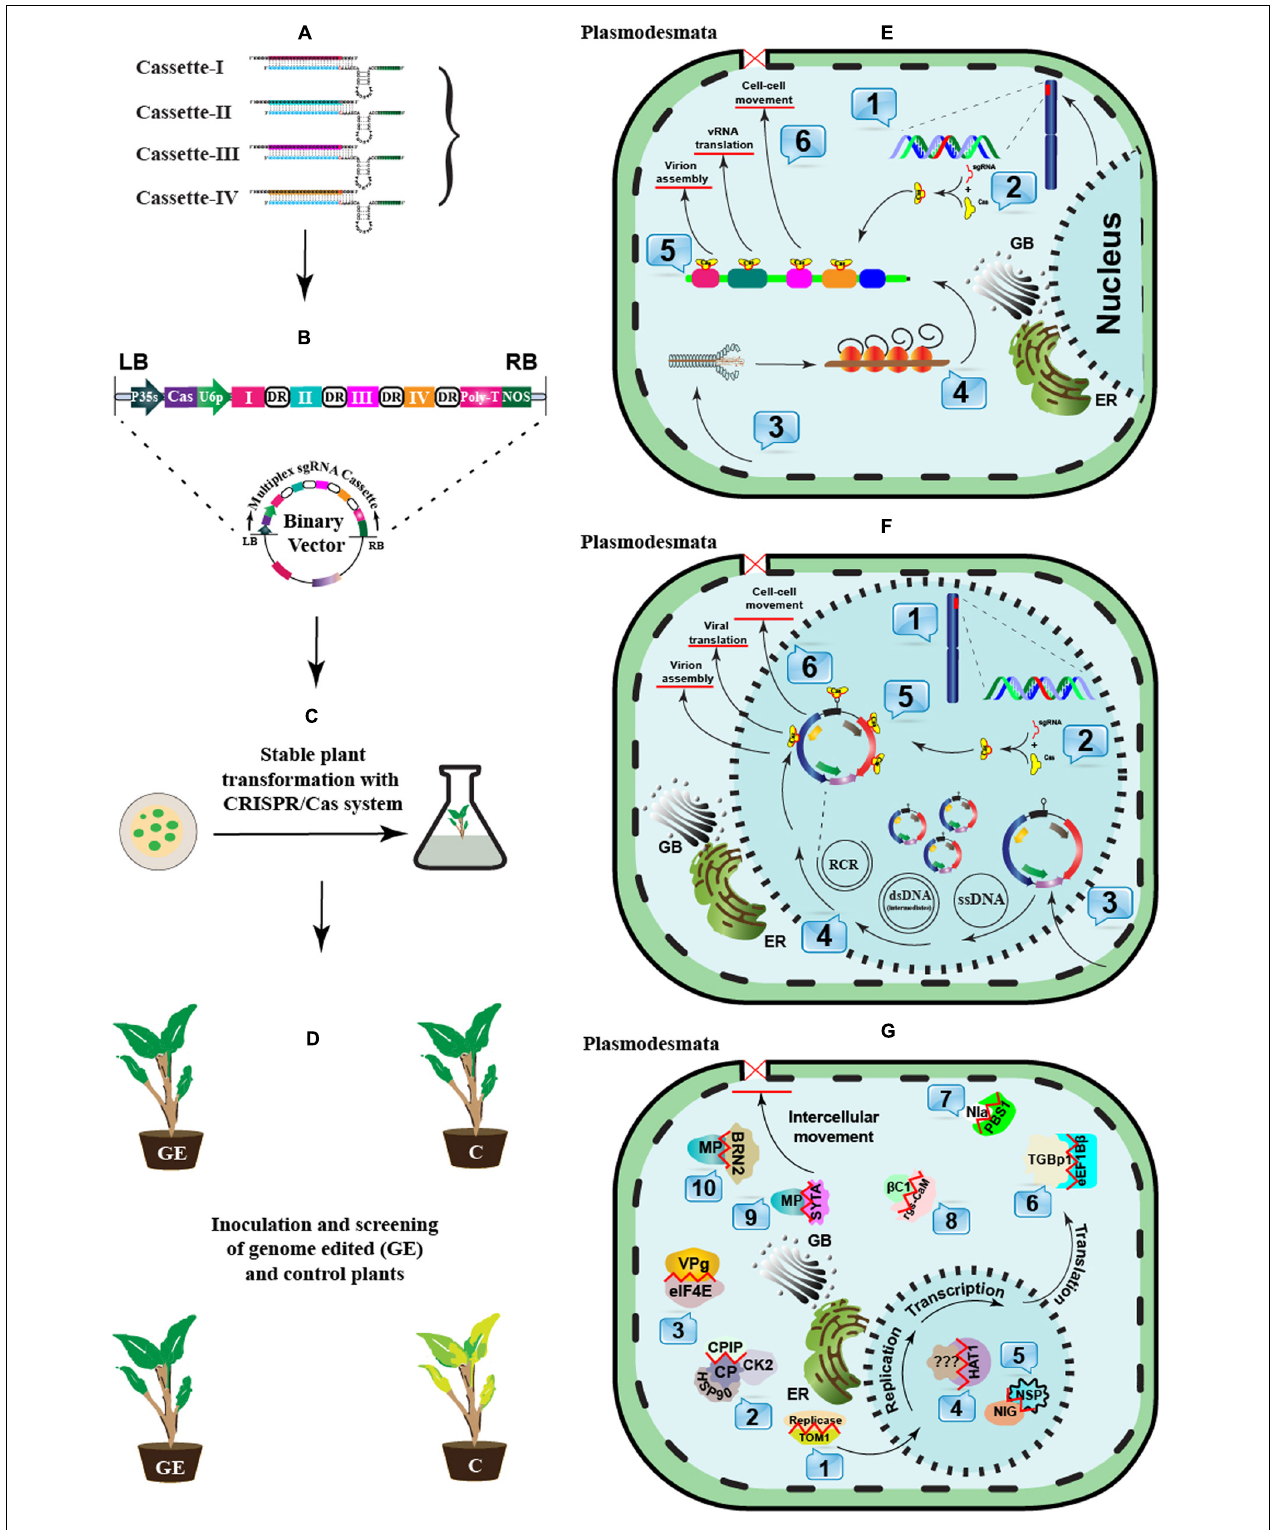
FIGURE 3 | A schematic approach to engineer CRISPR-Cas-based antiviral resistance in crop plants. (A) Designing of sgRNA to target the virus-encoded genes or the host susceptibility factors. (B) Construction of a cassette to express multiple sgRNAs and Cas protein under suitable promoters. The Cas protein can